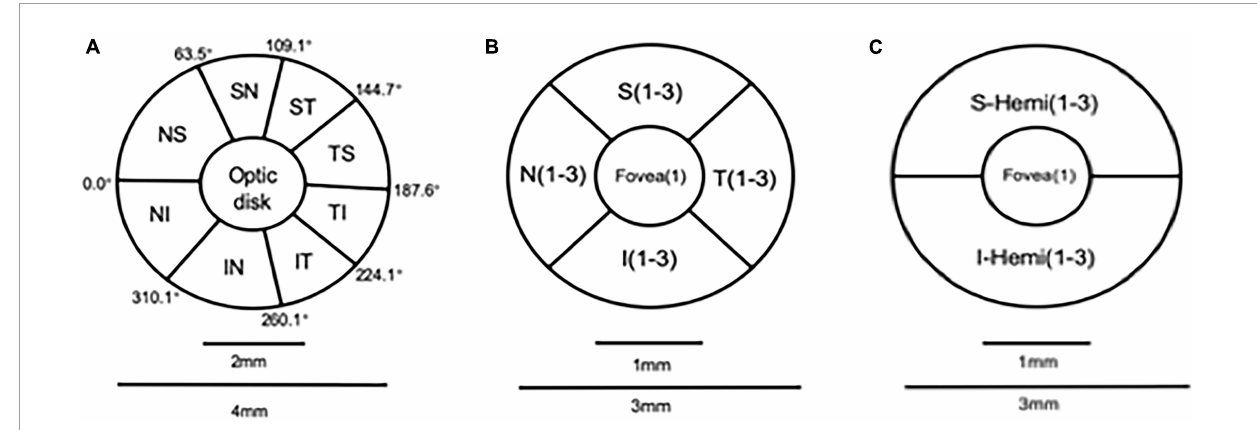
FIGURE1 Optic disc partition mode diagram: (A) Garway-Heath map (eight parts); angio retina macular partition mode diagram: (B,C) Hemisphere and Quadrant Maps.